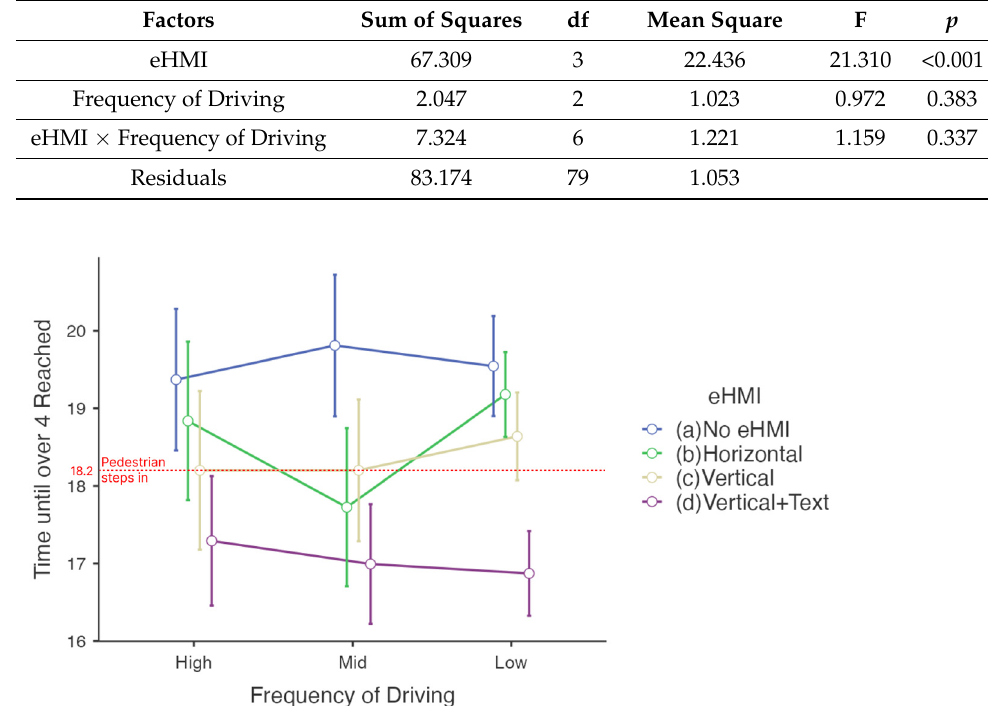
Table 7. Post-hoc comparison of the time till reach the maximum of the willingness to stop within the low frequency of driving